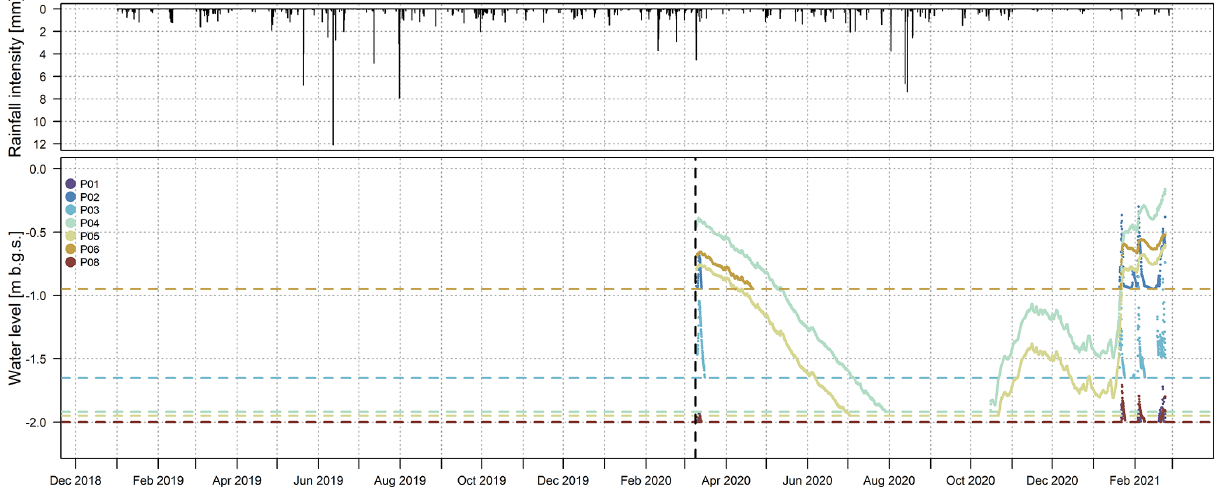
range, accuracy, and resolution of the other variables pro- vided within the data set described in this